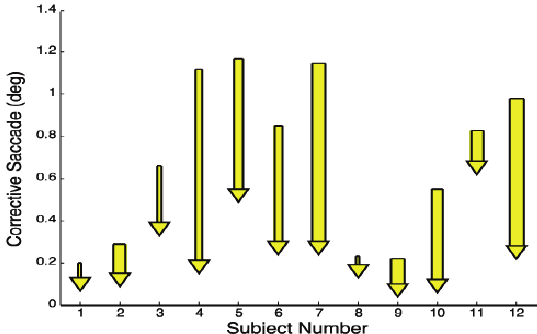
Figure 9 The average correction in symmetry error produced by symmetry-inducing saccades. Bar width indicates the percent symmetry-inducing saccades: 10% to 50%.